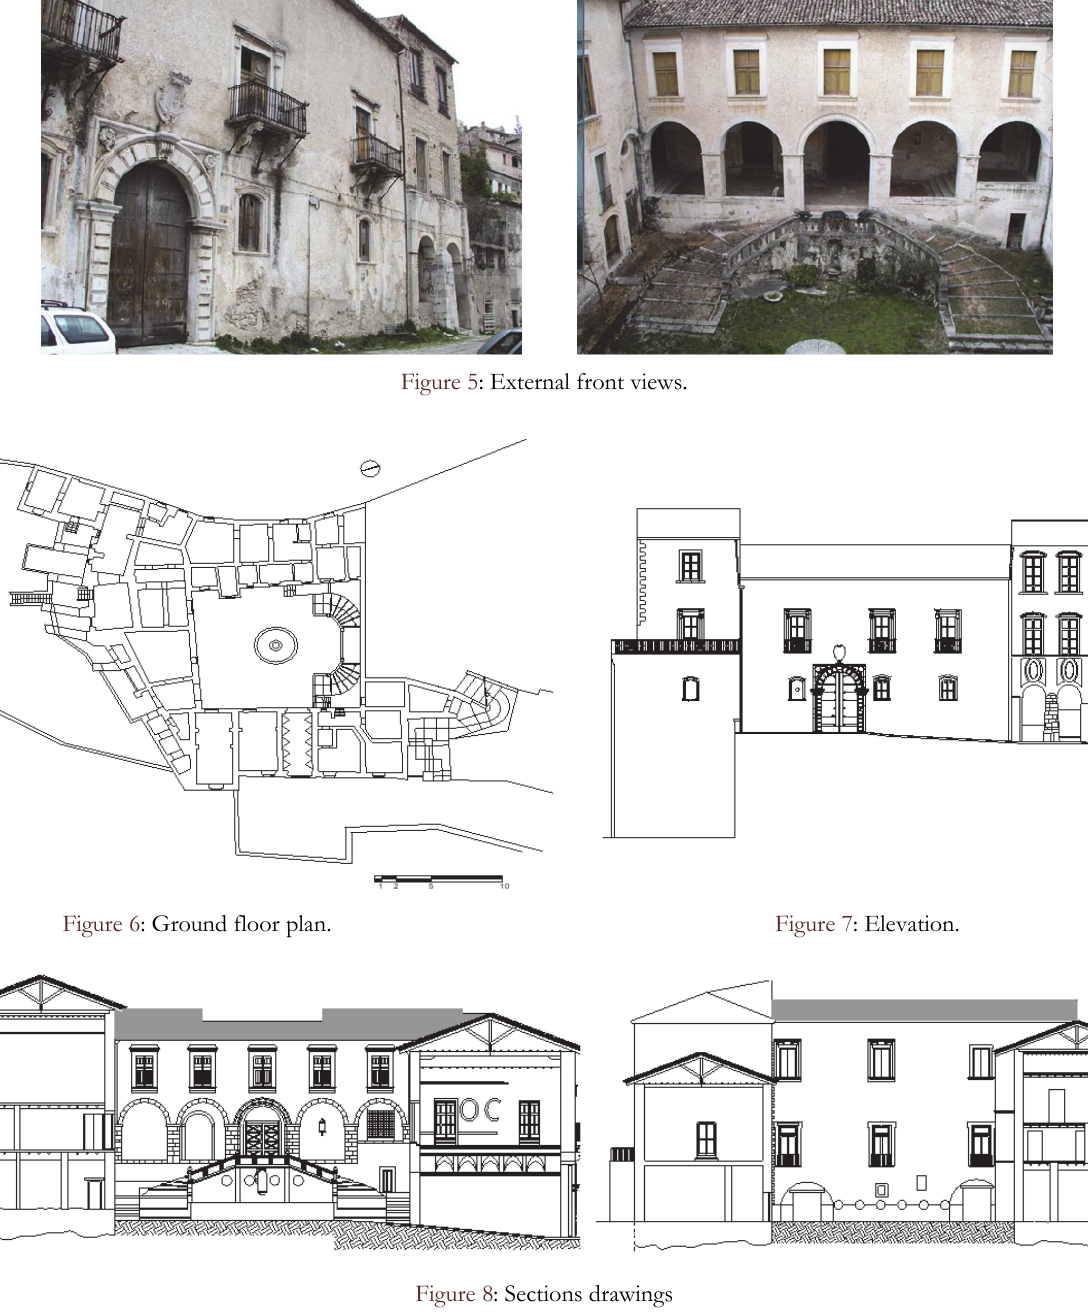
Figure 8: Sections